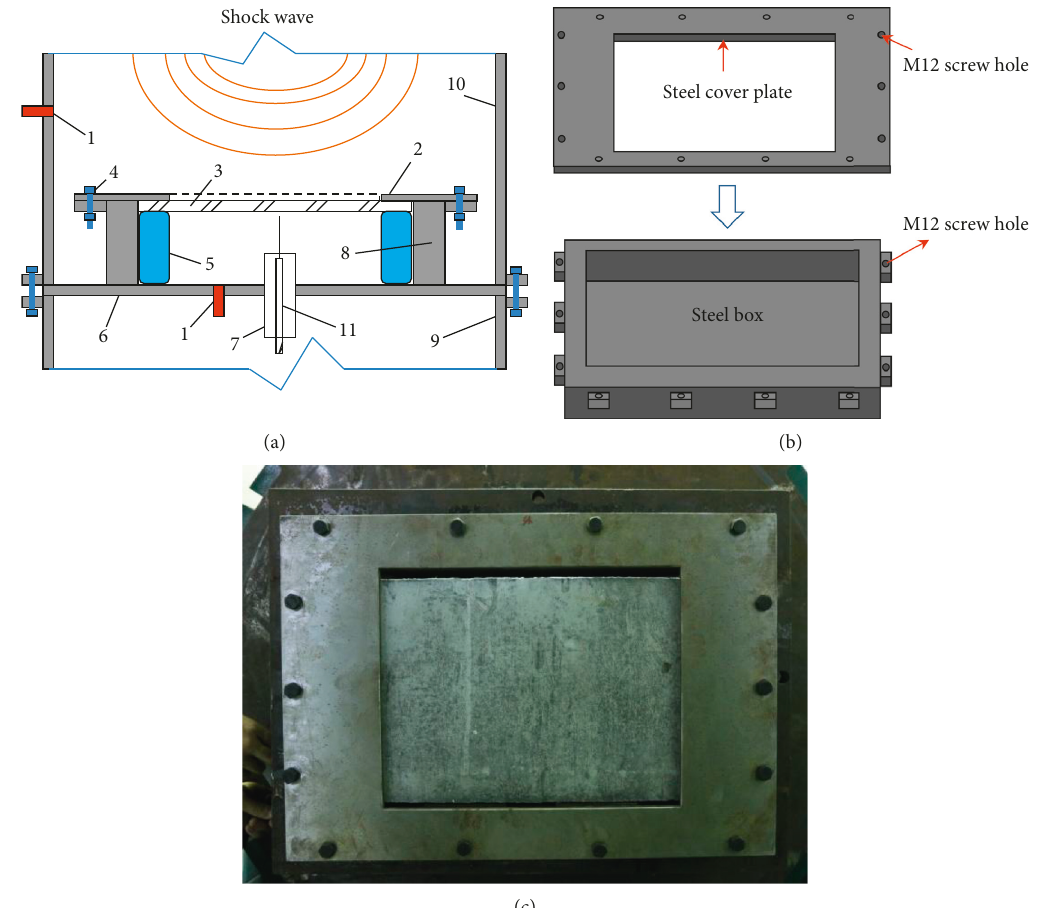
Figure 5: Setup in a shock tube. (a) Cross section of the target vessel: (1) pressure transducer; (2) steel cover plate; (3) specimen; (4) M12 bolt; (5) steel support; (6) steel plate; (7) steel tube; (8) steel box; (9) dissipation ring; (10) target vessel; (11) LVDT. (b) Fixation device. (c) Fixed specimen.